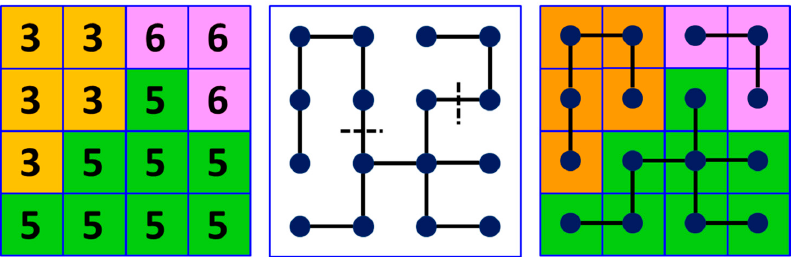
Figure 6. The principle of MST segmentation.